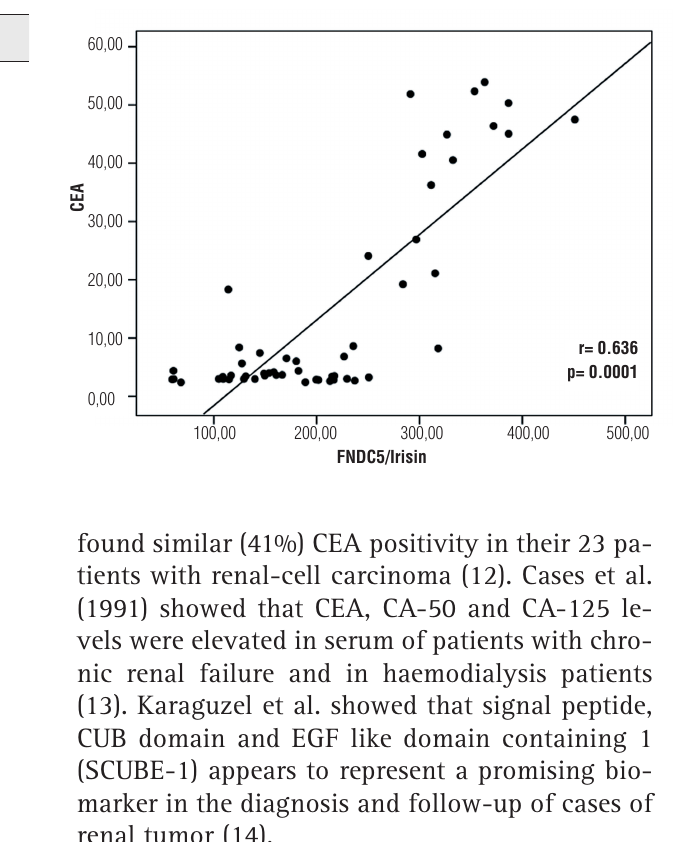
Table 3 - The pathological distribution of the tumors in patients.